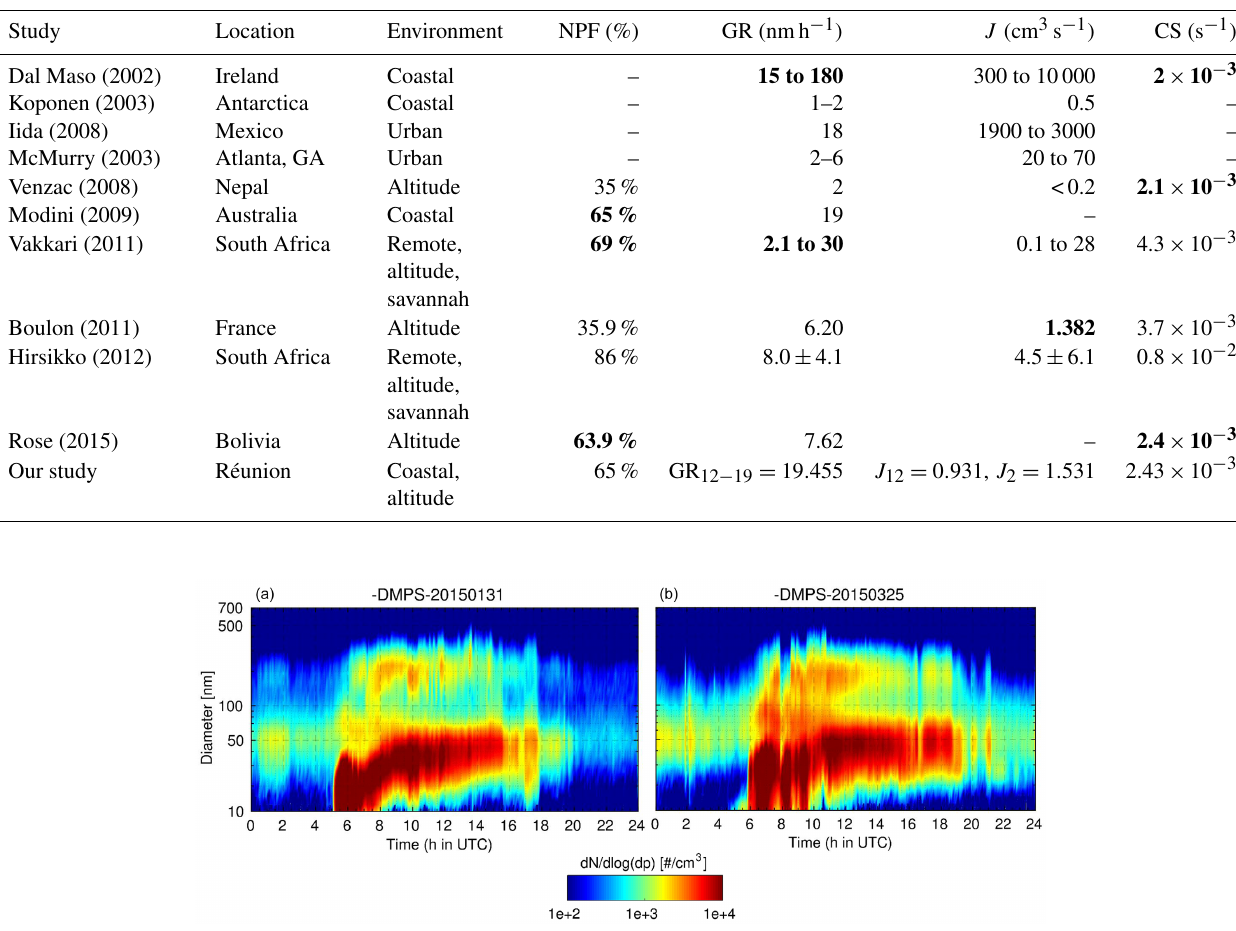
Table A2. Comparison of NPF frequency, GR, J and CS values.